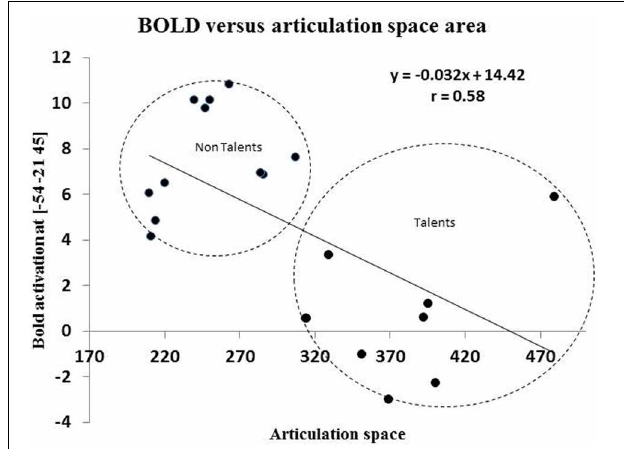
FIGURE 8 | This figures shows the correlation between BOLD activation of peak voxel [ − 54, − 21, 45] in the left inferior parietal cortex with the area spaces of the “Articulation Space” according to modulation spectrum